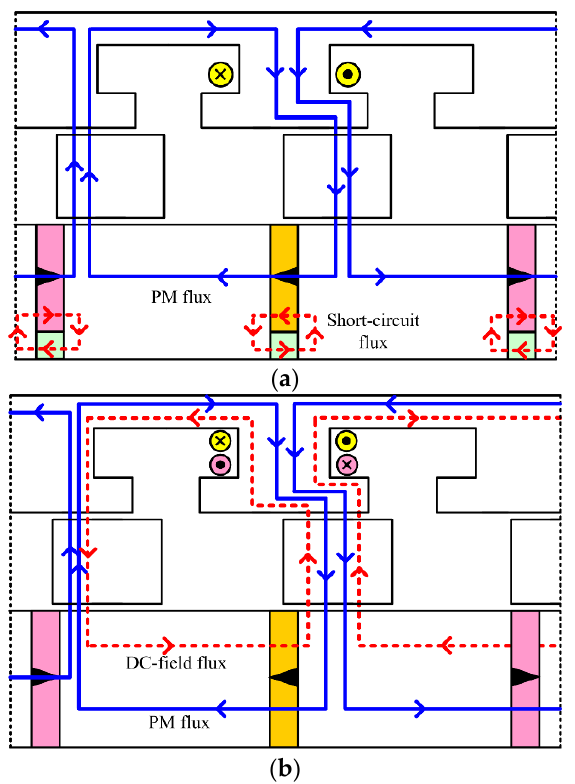
Figure 4. Flux-weakening principles: ( a ) FA-PS-SFPM; ( b ) PS-SFDE. Figures are modified with permission from [19], published by IEEE, 2017.